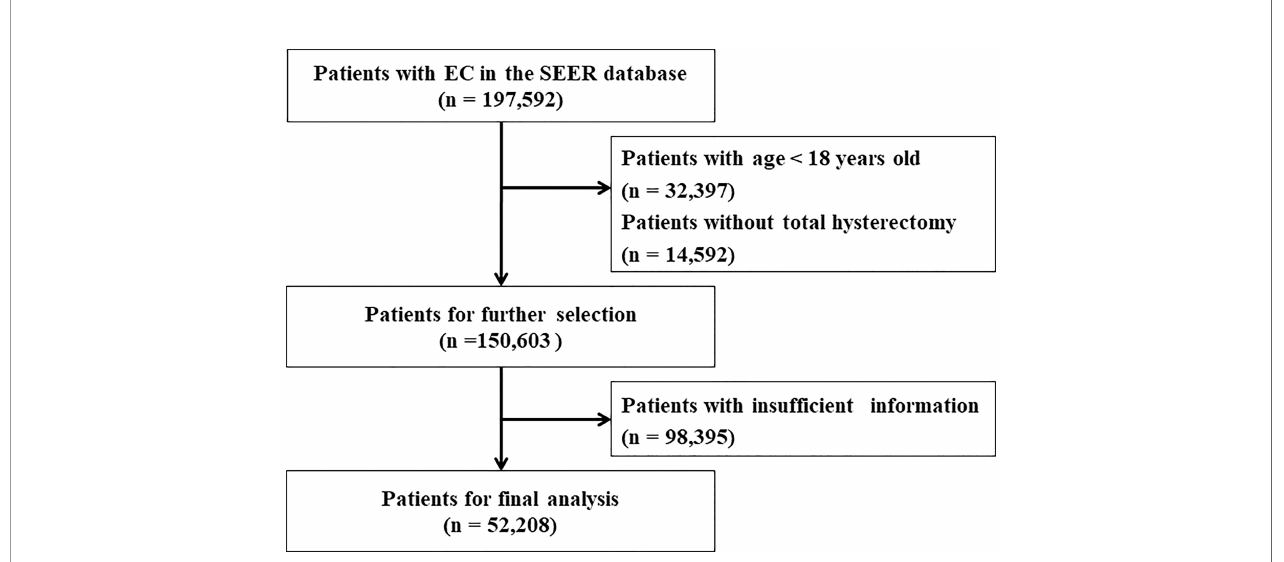
FIGURE 1 | Flow chart for screening eligible patients. EC, endometrial cancer. SEER, the Surveillance, Epidemiology, and End Results Program